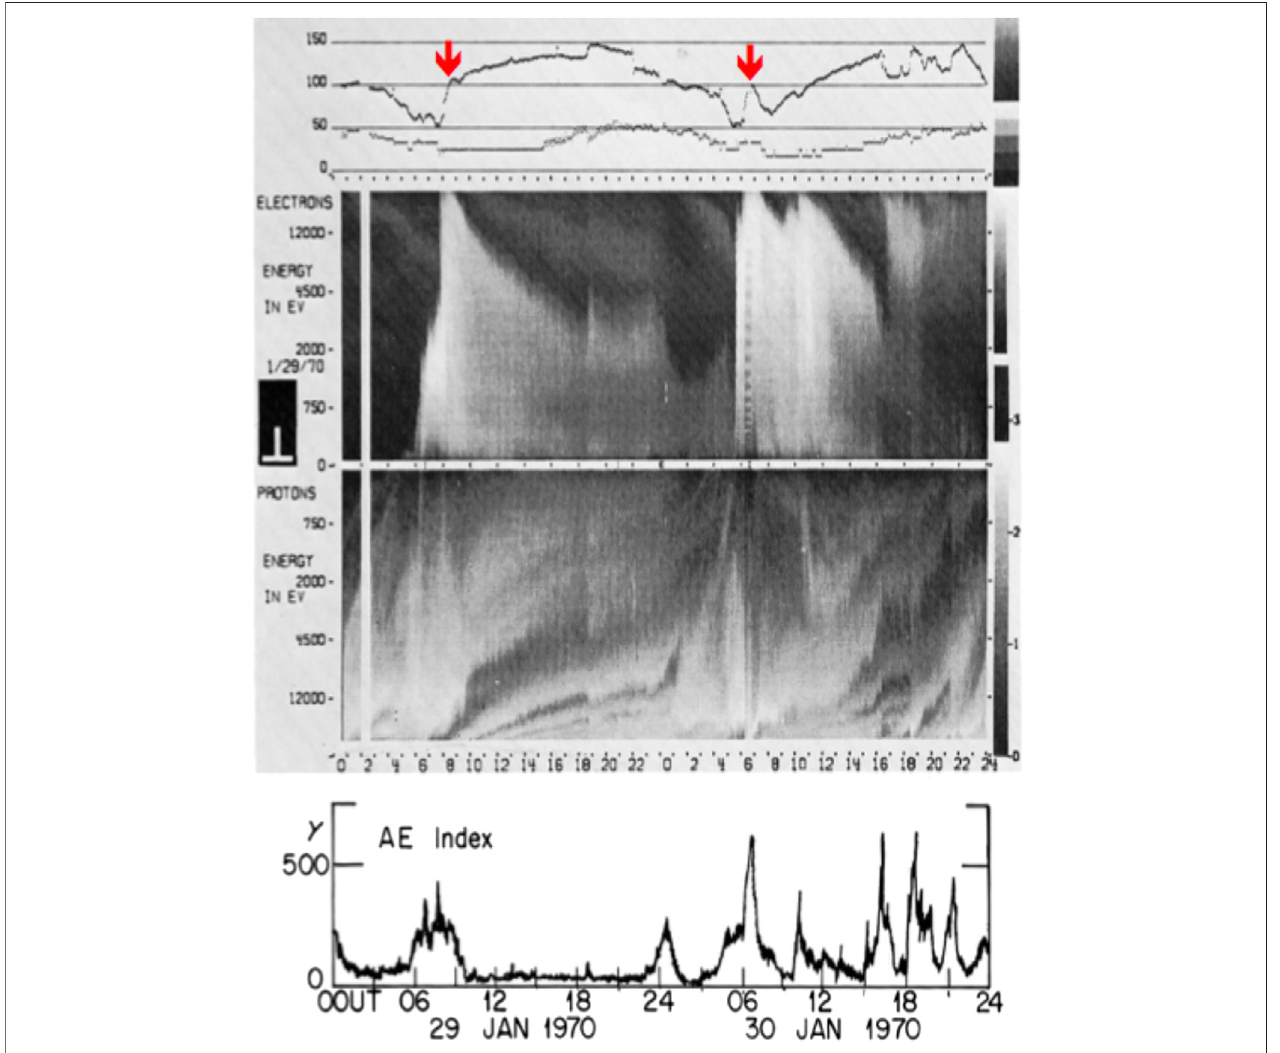
FIGURE 8 | The satellite observation (at 6Re) of the injection of electron (upper part) and protons (lower part) to the ring current belt (Deforest and McIlwain, 1971); the most energetic protons are injected fi rst and then lower ones.